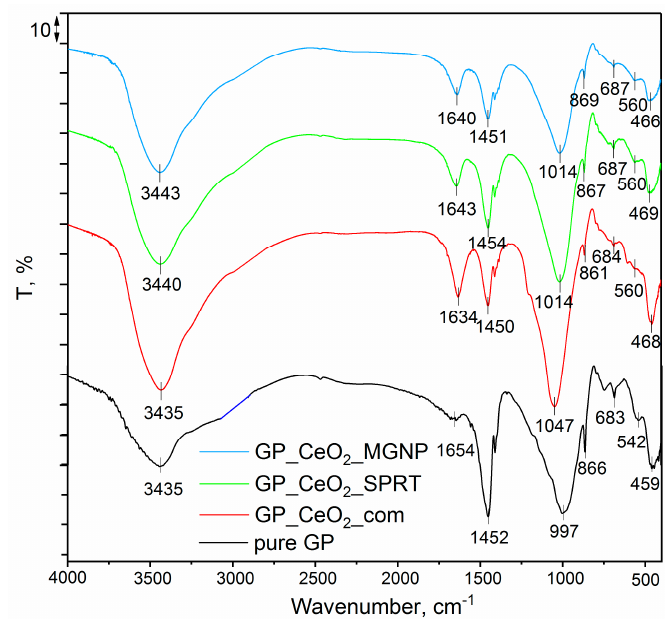
Figure 6. FTIR spectra of the pure GP, GP_CeO2_com, GP_CeO2_MGNP, and GP_CeO2_SPRT samples.